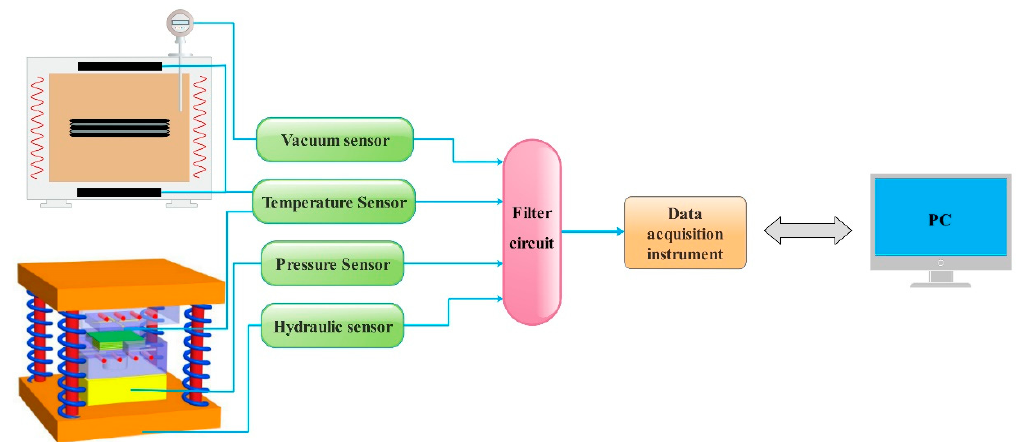
Figure 5. Schematic diagram of the structure and principle of the VIHPS parameter acquisition and control system.